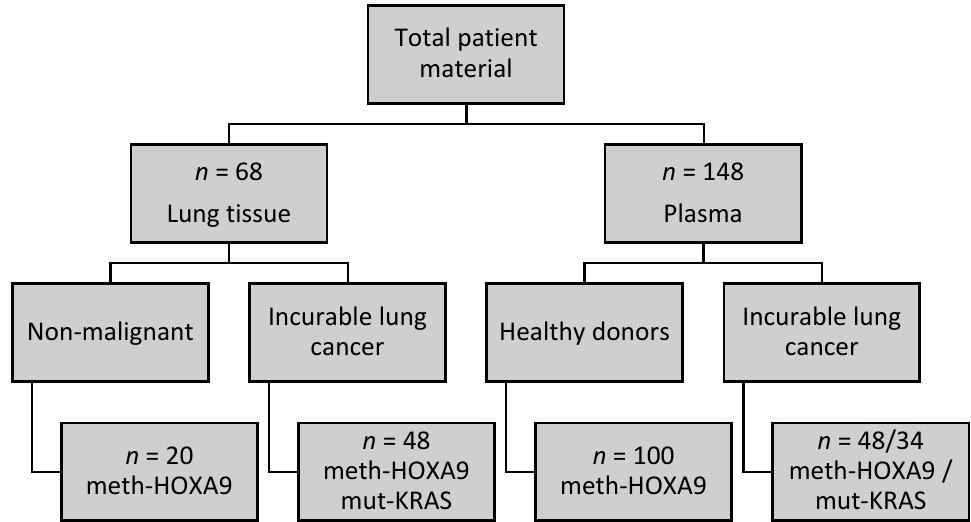
Figure 4. Biologic material. Flow chart illustrating the types of biologic samples available, number of samples analyzed, and which markers were analyzed in each cohort. Tumor and patient plasma samples were matched. Mutated Kirsten rat sarcoma viral oncogene homolog (mut-KRAS) was only analyzed in plasma from the patients with a KRAS mutation detected by next-generation sequencing (NGS) in tumor tissue.